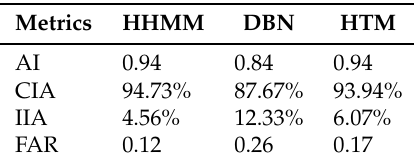
Table 9. Assessment of